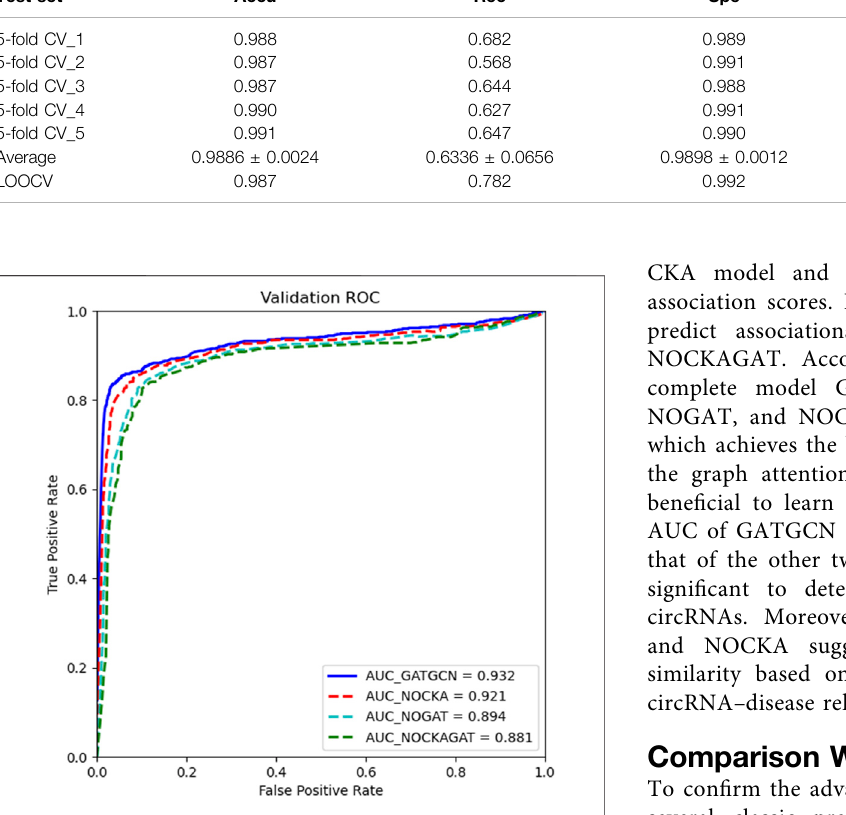
TABLE 1 | Results generated by the GATGCN under fi ve-fold CV and LOOCV. Test set